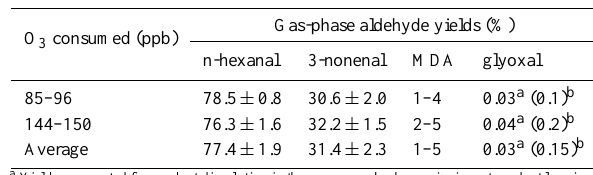
Table 1. Gas-phase aldehyde formation yields relative to the amount of ozone consumed from Type 1 experiments with LA. The uncertainties reflect the variation in results in 3 experiments, except in the case of glyoxal where the experiment was conducted once.